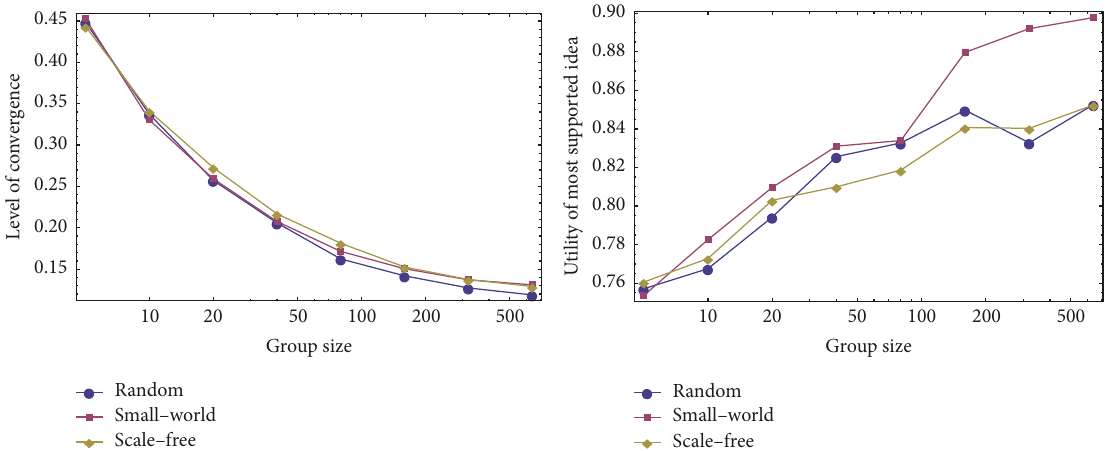
Figure 4: Effects of Group Size and Social Network Topology on Decision Convergence and Decision Quality . Note: Effects of group size ( N ) and social network topology (random, small-world, or scale-free) on the level of convergence (left) and the true utility value of the most supported idea (right). Note the log scale for group size. Each dot represents an average result of 500 independent simulation runs.